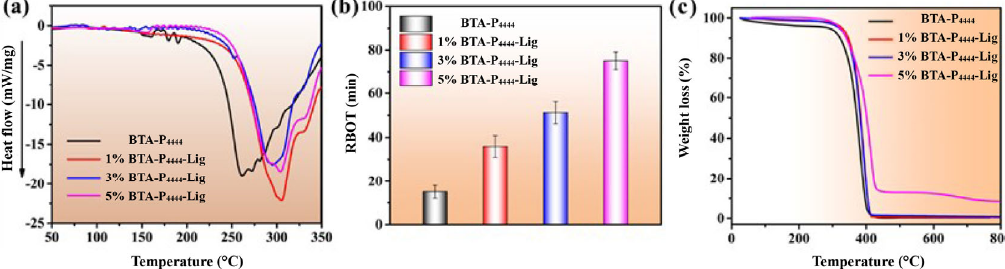
Fig. 13 Evaluation of oxidation resistance of Lig lubricating materials. Results of (a) TGA, (b) PDSC, and (c) rotating oxygen bomb method for BTA-P 4444 , 1% BTA-P 4444 -Lig, 3% BTA-P 4444 -Lig, and 5% BTA-P 4444